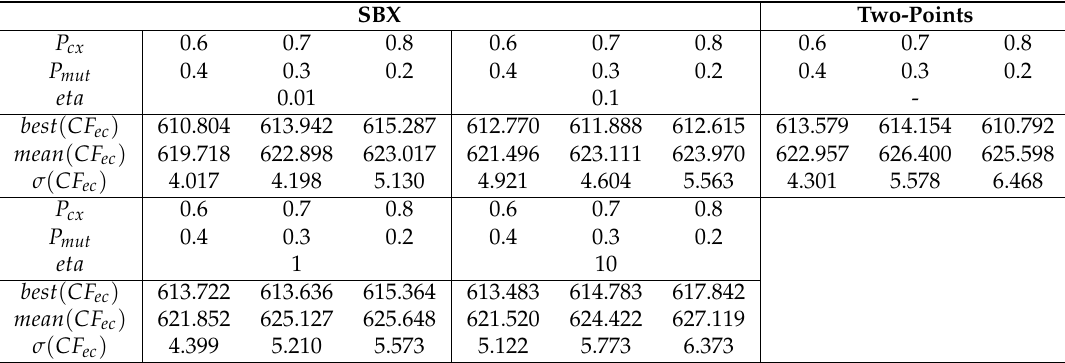
Table 8. Case-study 3